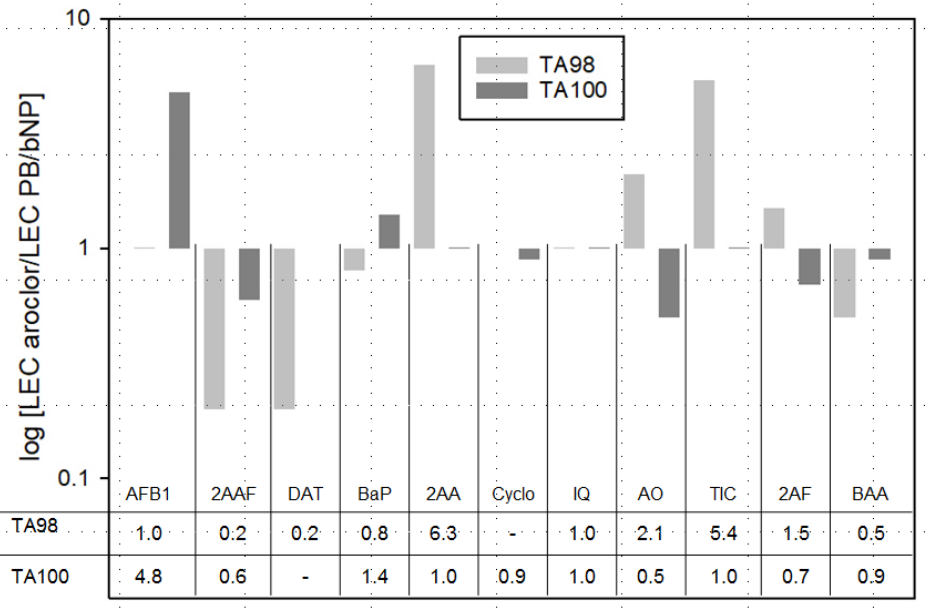
Figure 4. Relative differences in LECs for eleven substances tested with either Aroclor 1254 or PB/β-NP-induced S9, in the Ames MPF™ assay, are shown in logarithmic scale. The factor was calculated by dividing the mean LEC of the Aroclor 1254-induced S9 by the mean LEC of the PB/β-NP-induced S9.